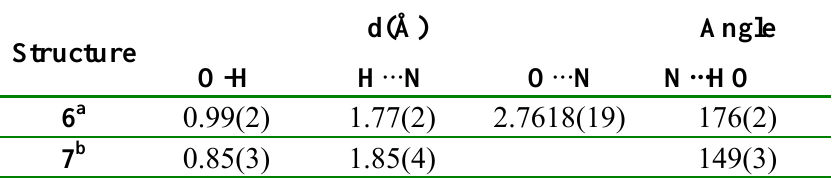
Table 2. Structural parameter of the hydrogen-bonded interactions in 6 and 7